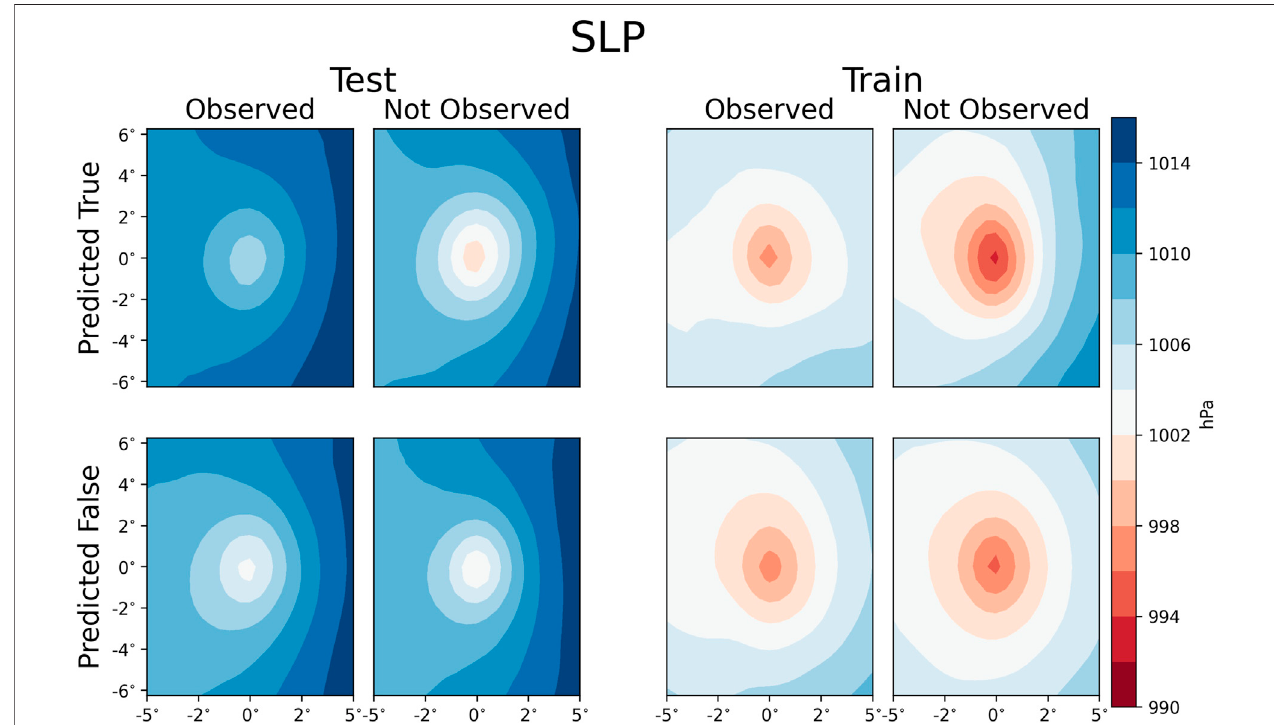
FIGURE 1 | Composite mean sea level pressure (SLP) for all of the contingencies of the machine-learning model.